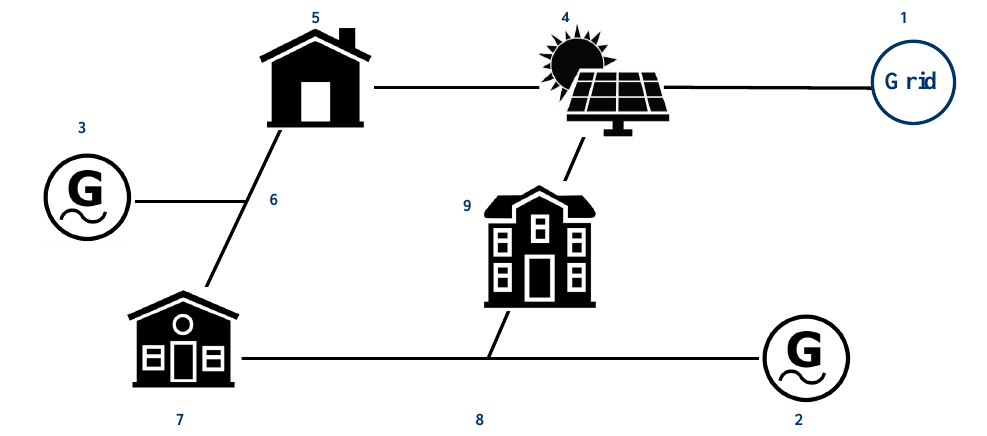
Figure 3. Topology of the 9-bus system; bus numbers are labeled by using arabic numerals (1–9).